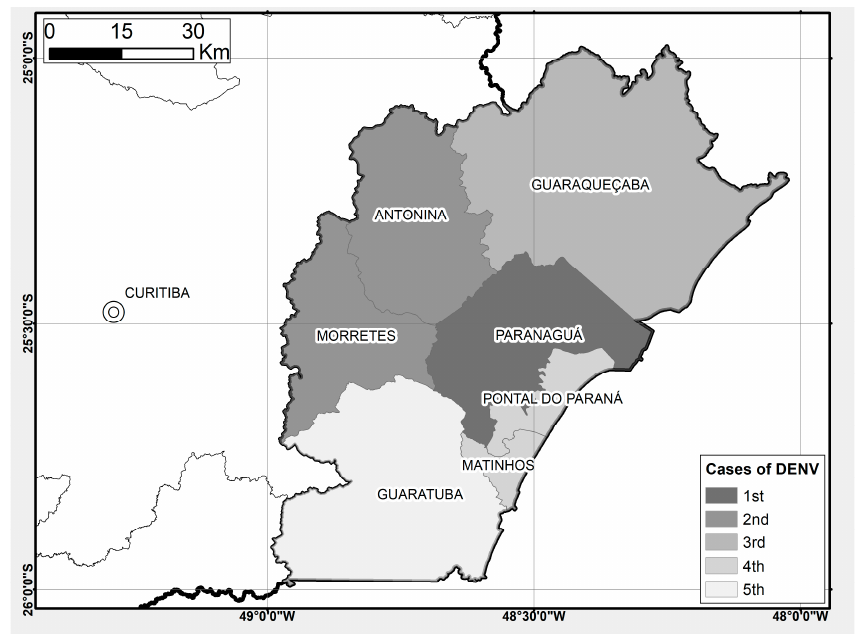
Figure 4. Detection timeline of DENV cases on the coast of the state of Paraná, Brazil.